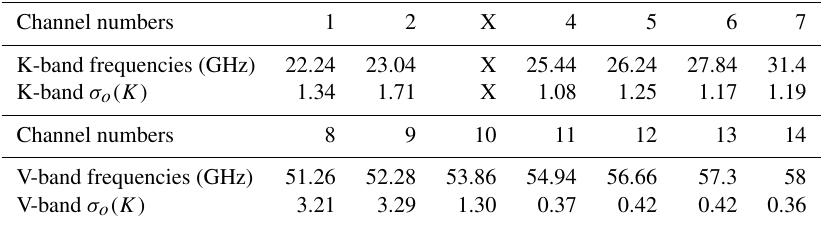
Table 1. Channel numbers, band frequencies (GHz) and observation uncertainties (K) prescribed in the observation error covariance matrix (from Martinet et al.,